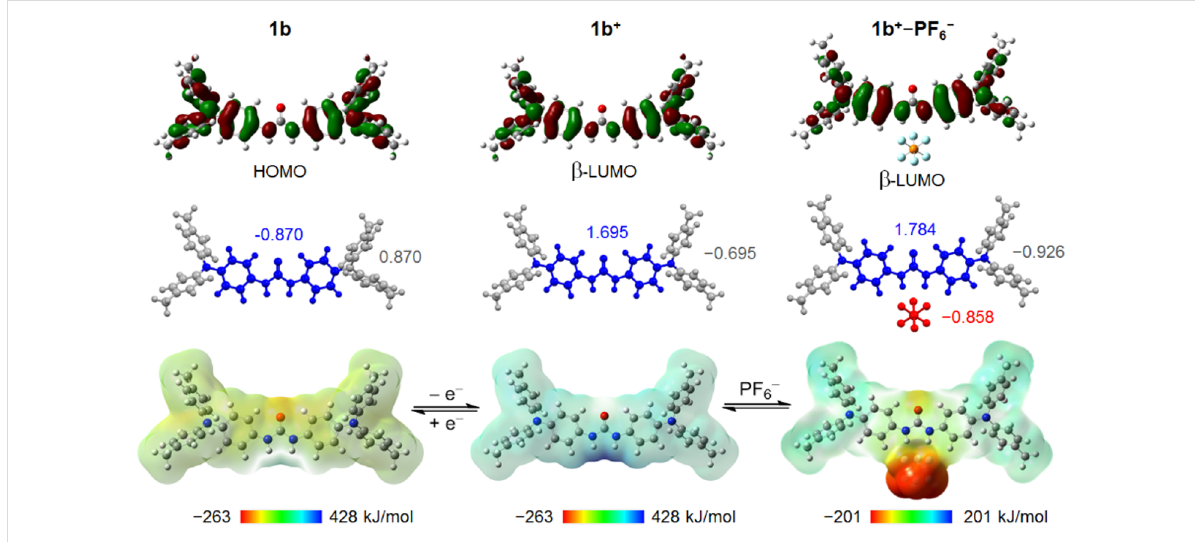
Figure 3: Key frontier orbitals (isosurface values 0.02 au) (top), DFT-optimized structures with Mullliken charges of peripheral tolyl groups (gray), nitrogen centers and bridging moieties (blue), and PF 6 − (red) (middle), and electrostatic potential maps (isosurface value 0.0004 au) of 1b , 1b + , and 1b + –PF 6 –